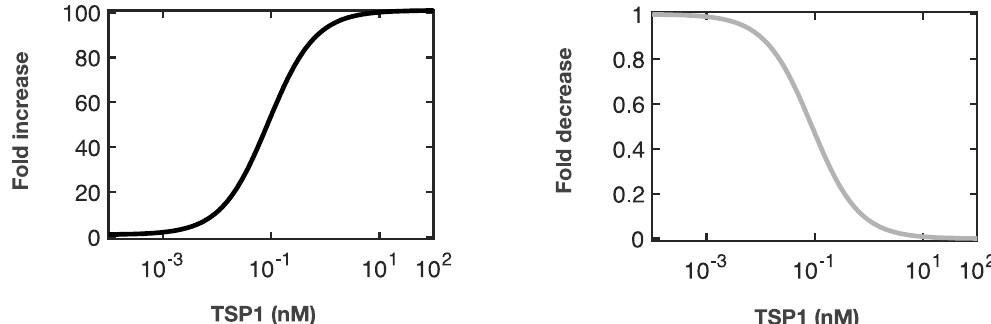
Figure 3. Hill functions of TSP1 concentrations. The model parameter value subject to variation is multiplied by f positive ( left panel ) or f negative ( right panel ) to increase or decrease its value, respectively, as a function of the TSP1 concentration.